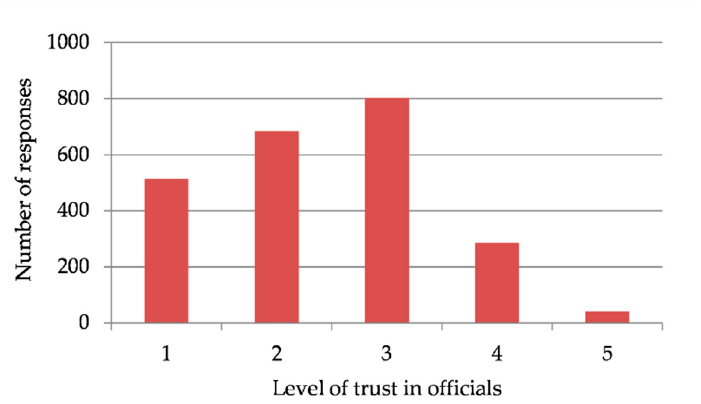
Figure 4. Distribution of survey responses on the ‘overall trust in the local authorities’ ability to protect the public’, on a five-point scale from 1—‘very low’ to 5—‘very high’.